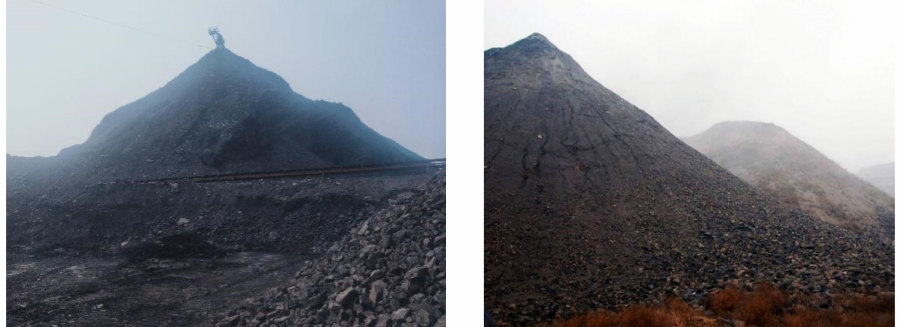
Figure 2. Waste coal